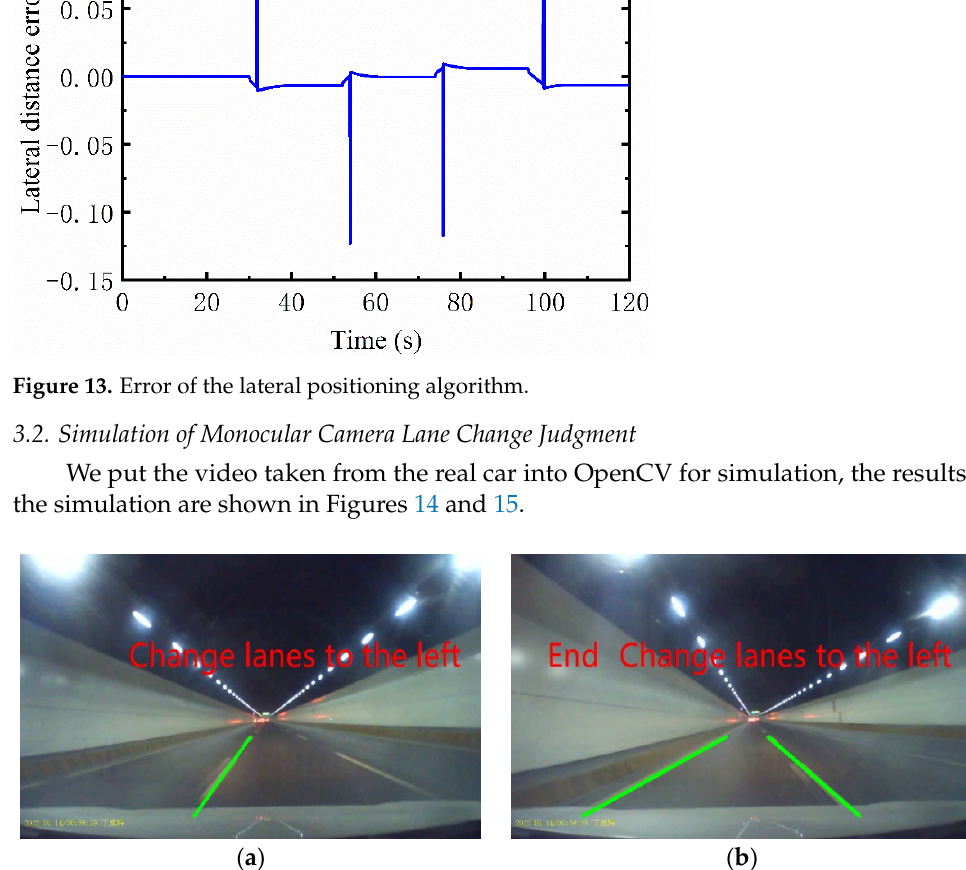
Figure 12. Lateral distance variation based on the algorithm of this paper: ( a ) Lateral distance vari-